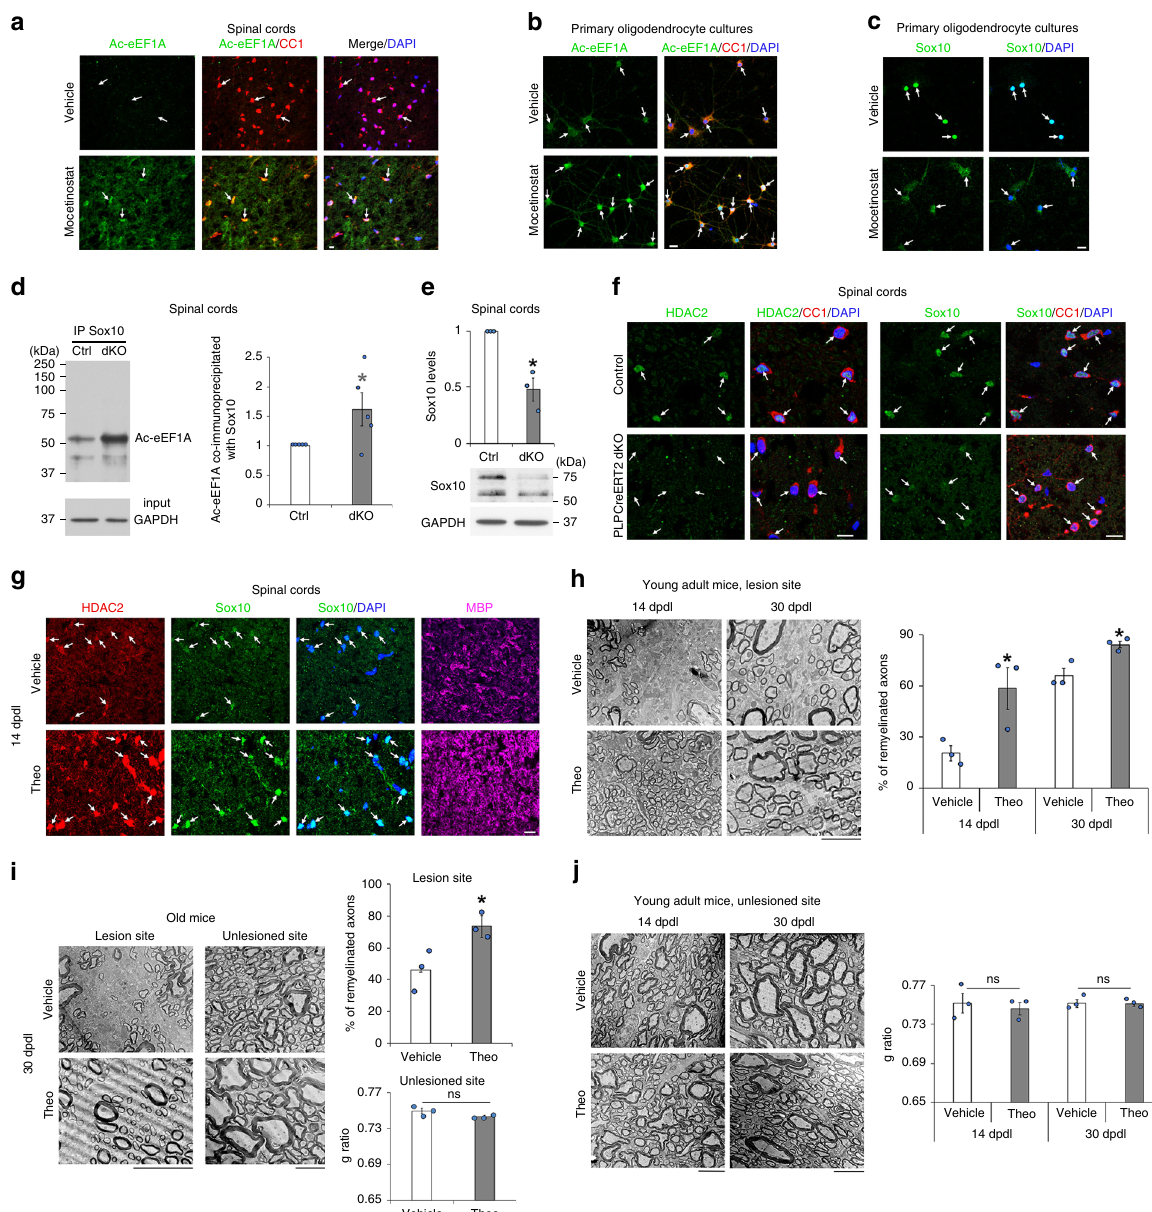
Fig. 9 Theophylline promotes CNS remyelination in young and old adults. a Co-immuno fl uorescence of Ac-eEF1A and CC1 (marker of mature OLs) and DAPI labeling in white matter of adult mouse spinal cord 24 h after treatment with mocetinostat or its vehicle. b , c Co-immuno fl uorescence of Ac-eEF1A ( b ) or Sox10 ( c ) with CC1 and DAPI labeling in differentiated primary OLs treated with mocetinostat or its vehicle for 24 h. d – f Co-immunoprecipitation (IP) of Ac-eEF1A with Sox10 ( d ) or Sox10 Western blot ( e ) and quanti fi cation normalized to GAPDH, or co-immuno fl uorescence of HDAC2 or Sox10 with CC1 and DAPI labeling ( f ) in spinal cords of PLPCreERT2 ; Hdac1 fl / fl ; Hdac2 fl / fl (dKO) mice or control littermate (Ctrl) at 14 days post tamoxifen injections. g Co- immuno fl uorescence of HDAC2, Sox10 and MBP and DAPI labeling in the spinal cord lesion site of adult mice (3 – 4-month old) at 14dpdl after a 4-day treatment with theophylline (Theo) or its vehicle. Arrows indicate OLs. h – j Electron micrographs of spinal cord ultrathin sections in the lesion site ( h , i ) or unlesioned site ( i , j ) at 14 and/or 30dpdl in young adult (4-month old) ( h , j ) or old (19-month old) ( i ) mice, and % of remyelinated axons in the lesion site (delineated by axons with thin myelin, g ratio ≥ 0.835) or g ratio in unlesioned site. Data are presented as mean values ± SEM. Unpaired ( h , i , j ) or paired ( d , e ) one-tailed (gray asterisk) or two-tailed (black asterisks) Student ’ s t -tests, p values: 0.047387 ( d ), 0.036845 ( e ), 0.043182 ( h , 14dpl), 0.018162 ( h , 30dpl), 0.127958 ( i , unlesioned), 0.03517 ( i , lesion), 0.328856 ( j , 14dpl), 0.447458 ( j , 30dpl). d n = 5 animals per group, ( e ) n = 3 animals per group, ( h – j ) n = 3 animals per group per time-point. Representative images of 3 animals per group ( a , f , g ) or of 3 independent experiments ( b , c ) are shown. Scale bars: white = 10 µ m, black = 5 µ M. Source data are provided as a Source Data fi